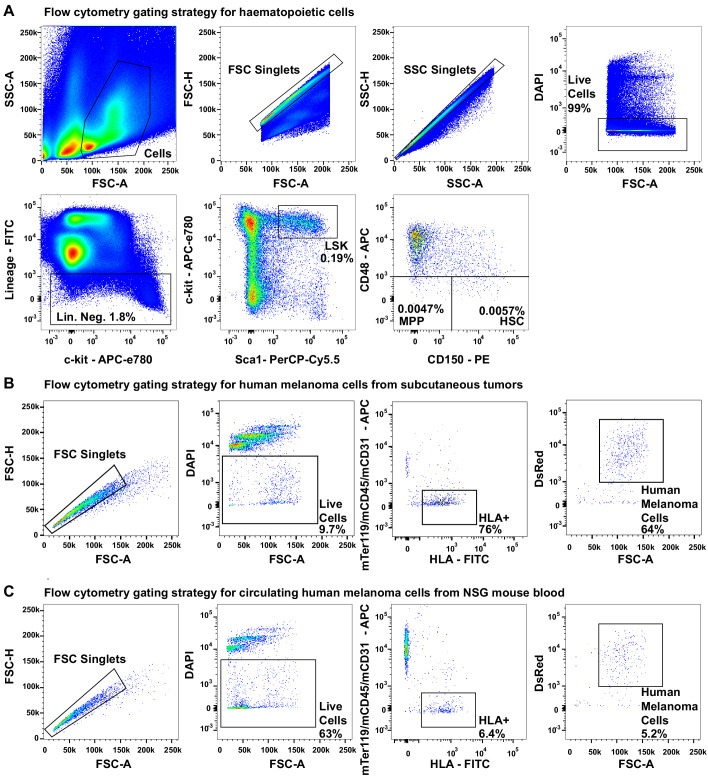
Flow cytometry gating strategies.(A) Flow cytometry gating strategies for isolating CD150+CD48-Lin-Sca1+c-kit+ hematopoietic stem cells (HSCs; 0.0057% of bone marrow cells), CD150-CD48-Lin-Sca1+c-kit+multipotent progenitors (MPPs; 0.0047% of bone marrow cells), and Lin-Sca1+c-kit+ cells (0.19% of bone marrow cells). (B) Flow cytometry gating strategy for isolating live HLA+DsRed+mTer119-mCD45-mCD31- human melanoma cells from mechanically dissociated subcutaneous tumors from xenografted NSG mice (all melanomas were tagged with stable DsRed expression). (C) Flow cytometry gating strategy for isolating live HLA+DsRed+mTer119-mCD45-mCD31- circulating melanoma cells from the blood of xenografted NSG mice.